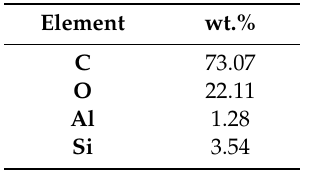
Table 3. Quantitative results of EDX analysis in wt.%.